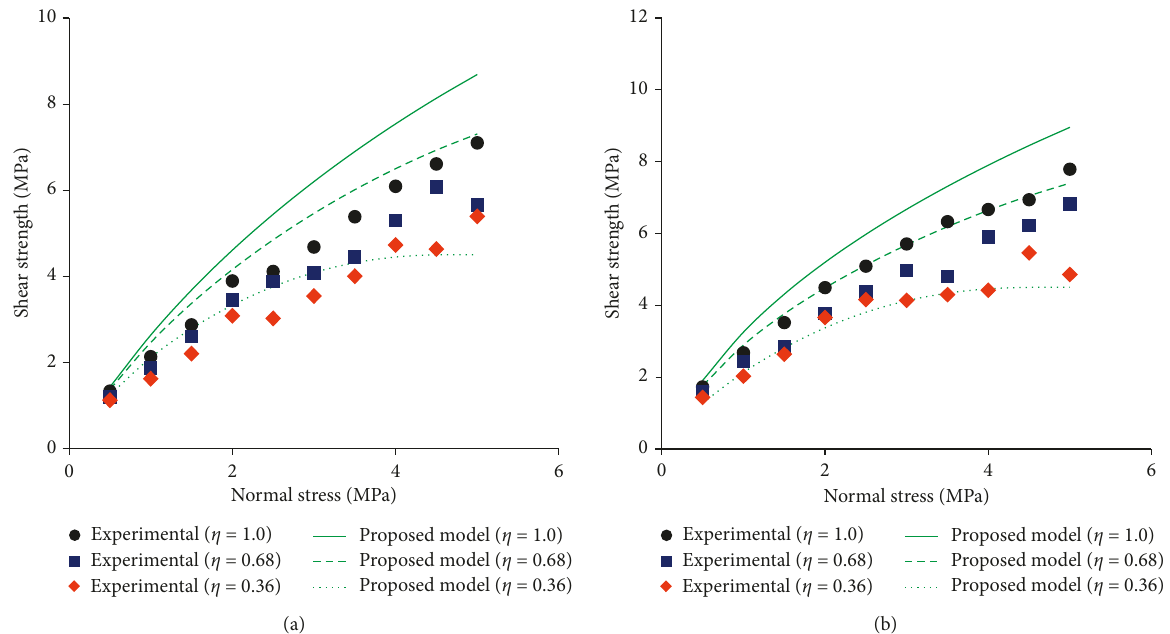
Figure 8: Model validation. (a) Comparison between proposed model and experimental data from fractures samples with 20 ° triangular asperities; (b) comparison between the proposed model and experimental data from fractures samples with 30 ° triangular